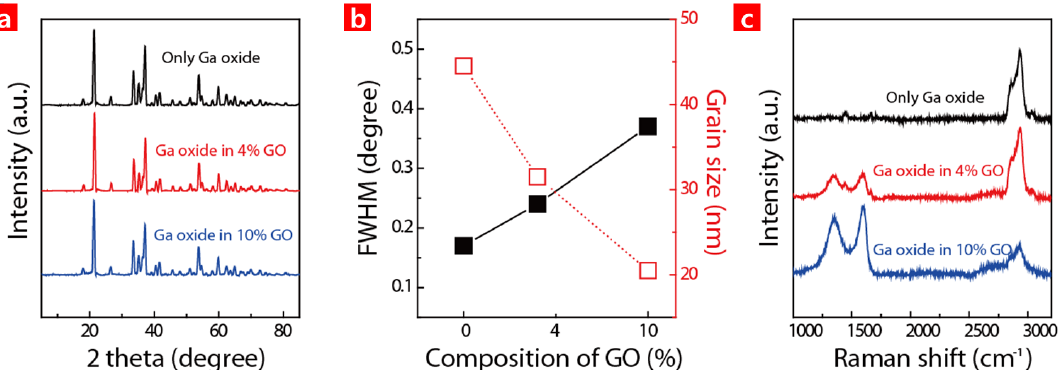
Figure 2. ( a ) X-Ray Diffraction (XRD) spectra of different HCs made up of gallium oxide (GaO) and with/without GO; ( b ) Full-width at half maximum (FWHM) variation for XRD peaks from ( a ) and grain size of the HCs as a function of GO concentration in the solution; ( c ) Raman of different HCs using the same proportions as in (a).